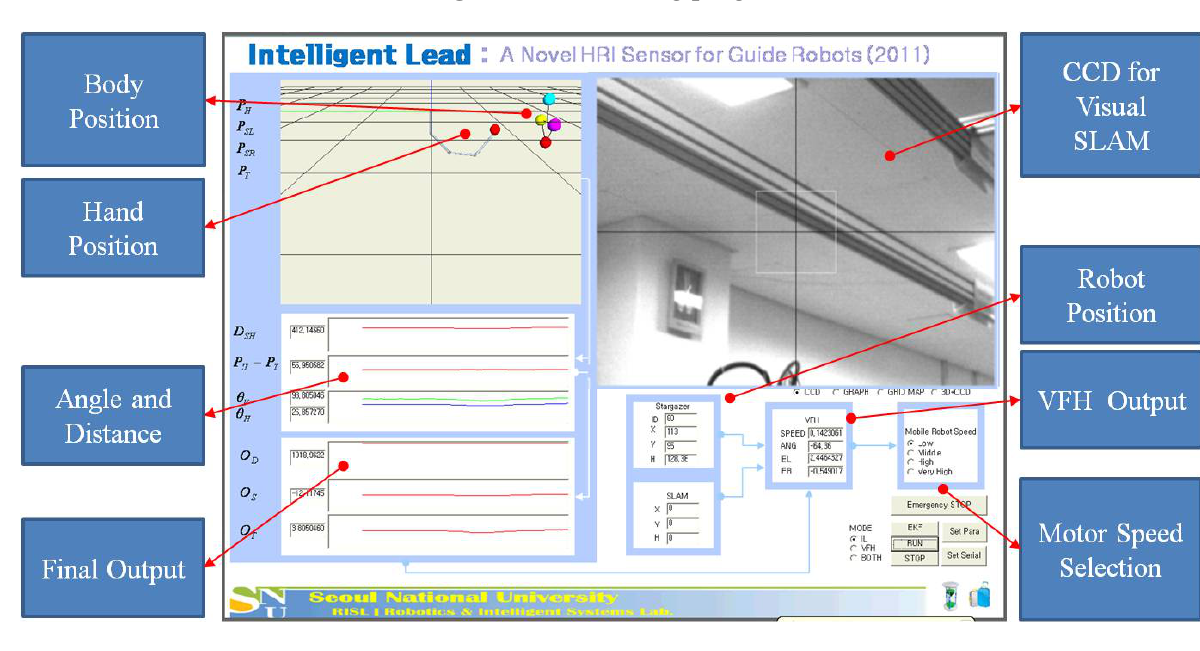
Figure 9. Monitoring